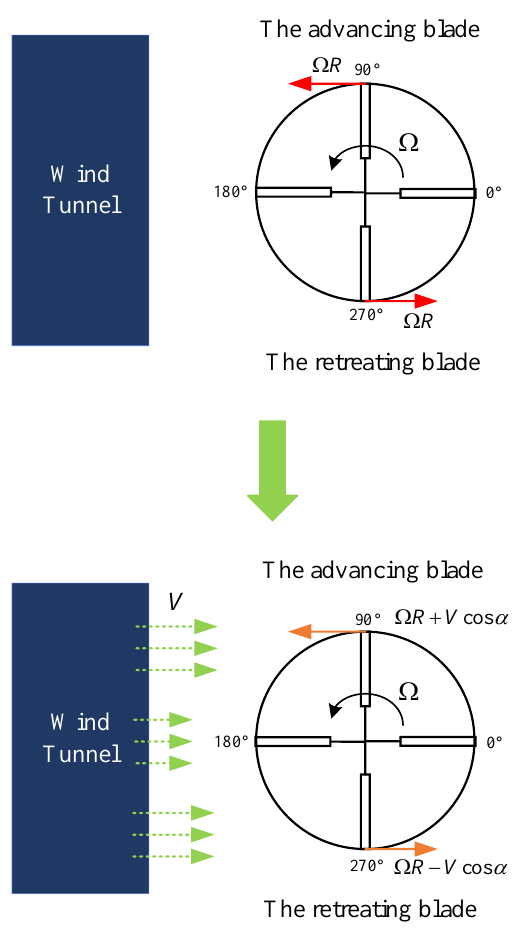
Figure 1. Trimming principle of helicopter wind tunnel test.